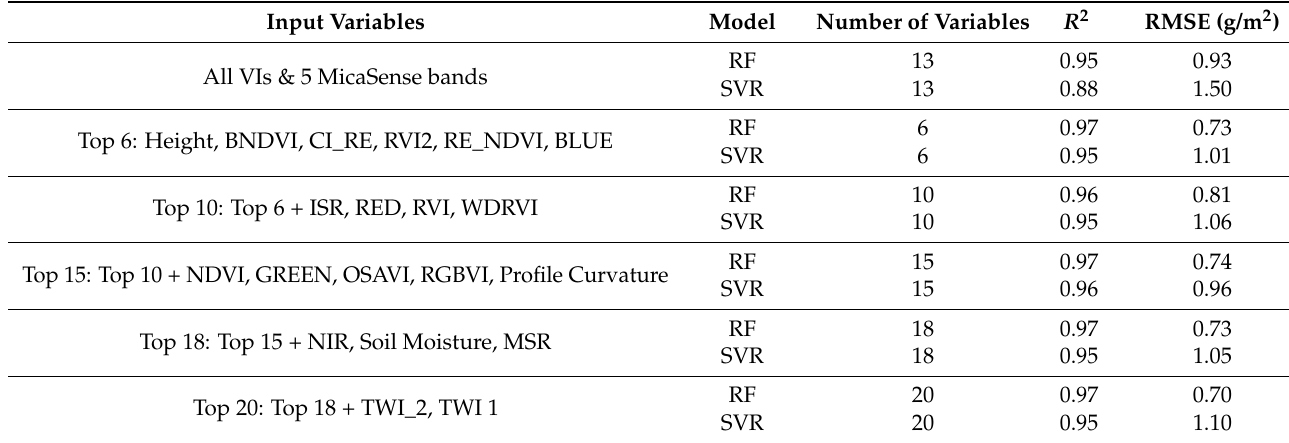
Table 6. Statistics for the calibration of the canopy nitrogen model with all dates (8, 15, and 24 June), and different combinations of variables ( n = 70) 1 .